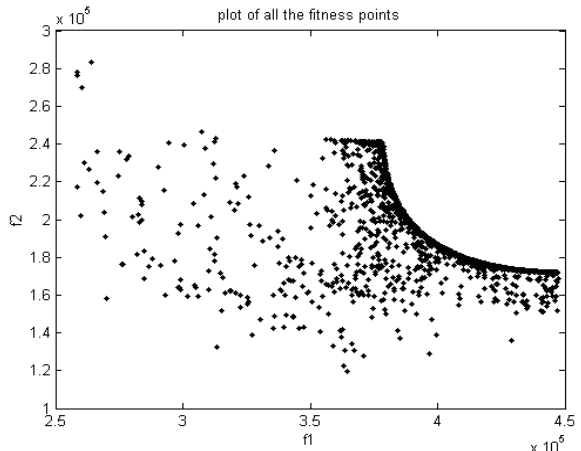
Fig. 8. Feasible domain with constraints on A11 (F 1 ) and A22 (F 2 ).